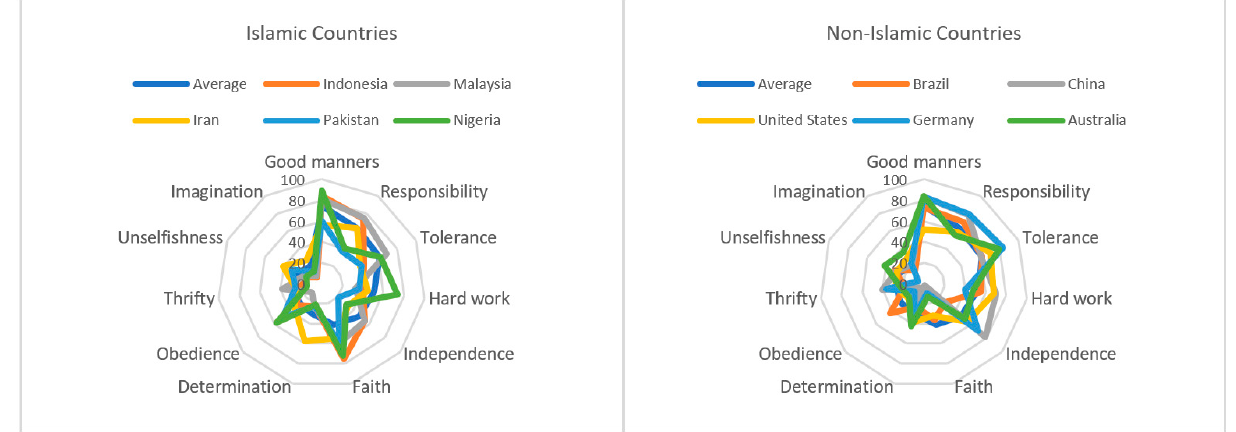
Figure 7. Qualities to develop for future generation by Islamic and Non-Islamic Countries.